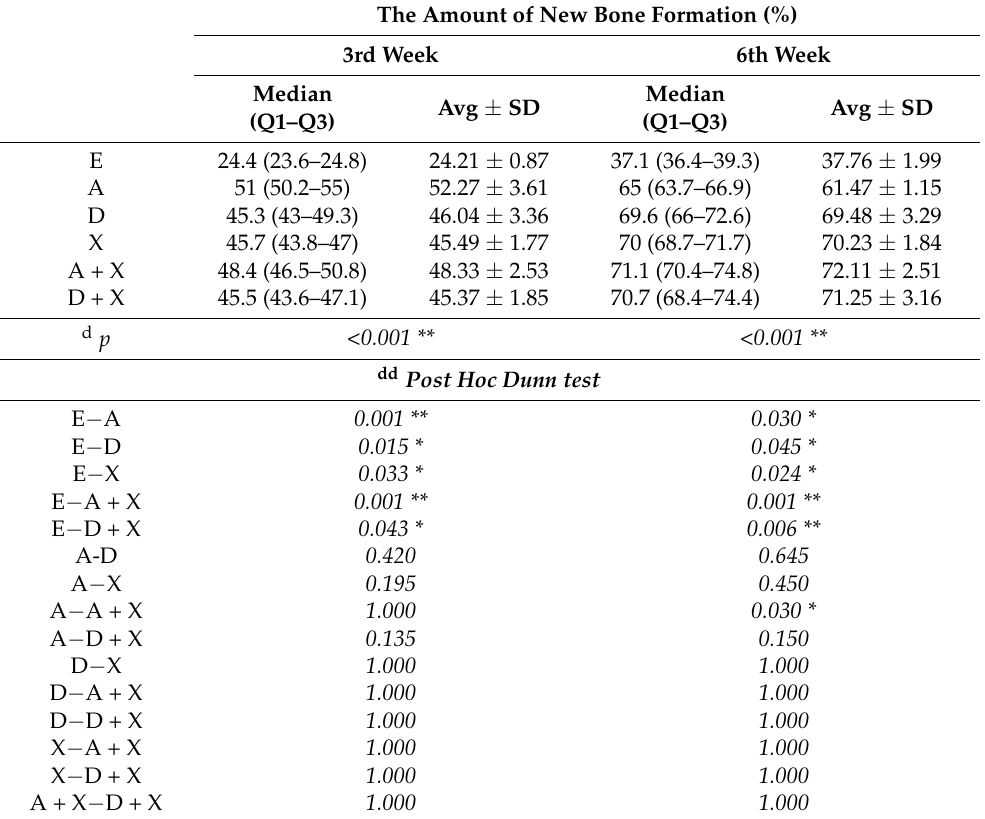
The Amount of New Bone Formation (%) 3rd Week 6th Week